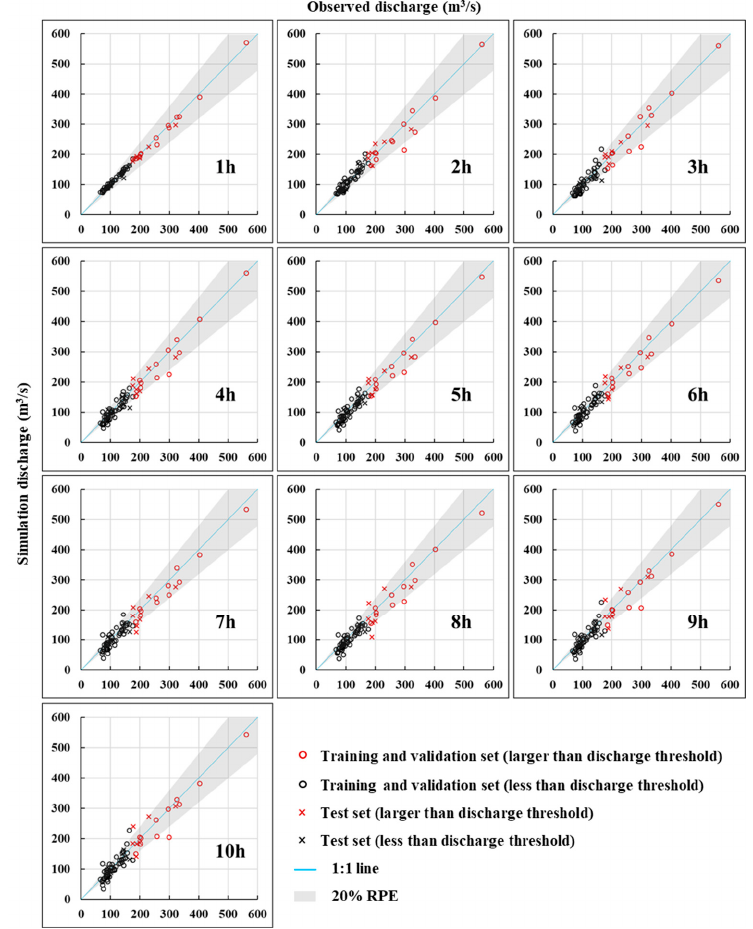
Figure 7. Simulated versus observed peak discharge.